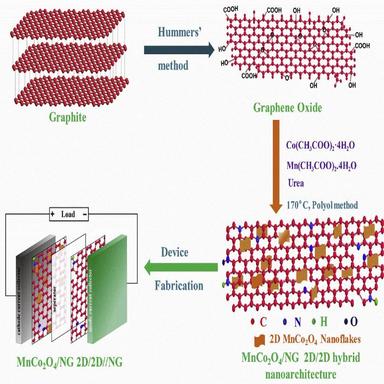
A schematic representation for the synthesis of MnCo2O4/NG 2D/2D hybrid nanoarchitectures and device fabrication for an asymmetric supercapacitor.